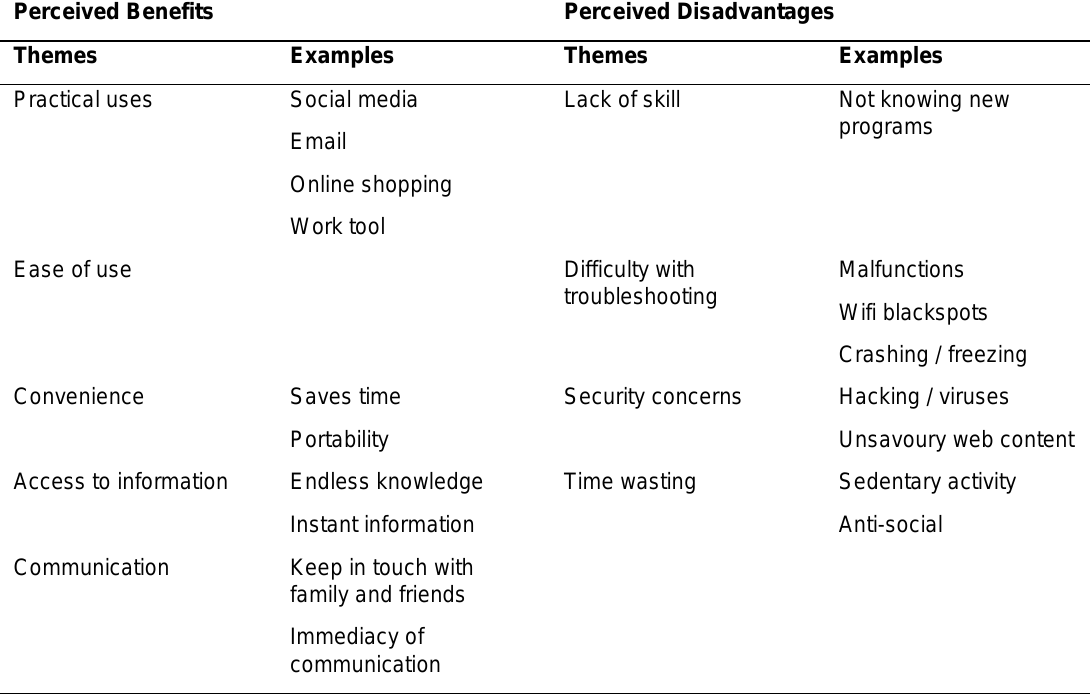
Table 3. Perceived Benefits and Challenges from Perspective of Participants Perceived Benefits